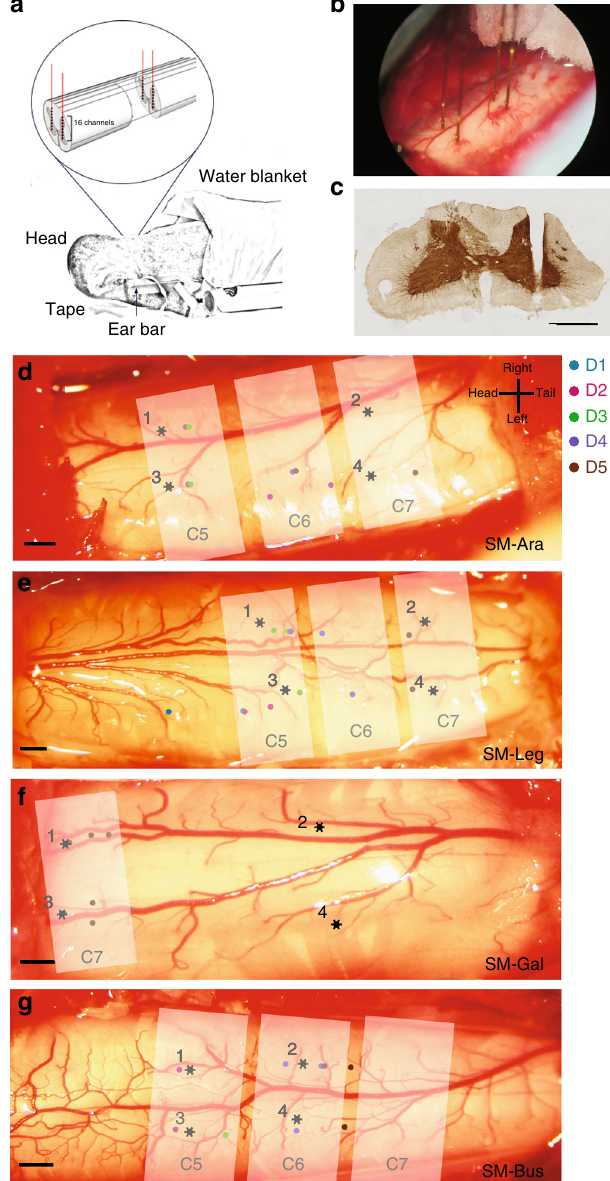
Fig. 6 Electrophysiological recording setup, recording sites, and maps of different digit segments for the four squirrel monkeys (SMs). a Schematic diagram of the spinal cord inserted with four electrodes, each with 16 channels that are 150 μ m apart. b Sample photograph of the four inserted electrodes in SM-Ara. c Cytochrome oxidase stain used to verify electrode penetrations of the spinal cord by identifying the electrolytic lesion. Exposed spinal cord with mapped digit regions (color dots) and recording sites (black asterisks) for ( d ) SM-Ara, ( e ) SM-Lego, ( f ) SM-Gua, and ( g ) SM-Bus. Scale bars represent 1 mm. Shaded white regions are estimated segments of the spinal